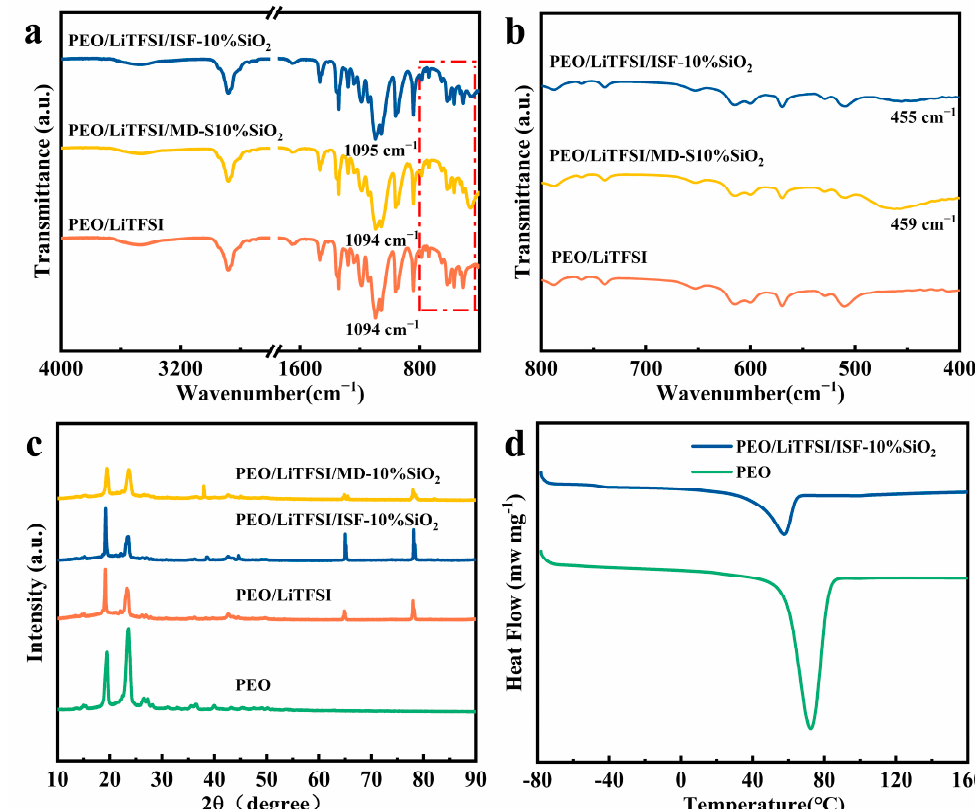
Figure 3. ( a ) FTIR spectra of as-spun SPEs. ( b ) Local magnification of 400–800 cm − 1 in ( a ). ( c ) X-ray patterns and ( d ) DSC curves of as-spun SPEs.